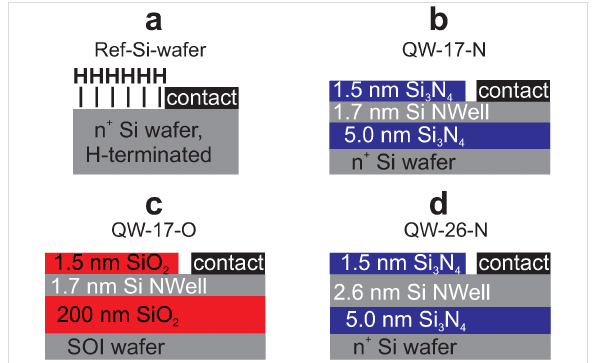
Figure 3: Structures of samples investigated by synchrotron UPS: (a) Si-reference, (b) 1.7 nm Si-NWell in Si 3 N 4 , (c) 1.7 nm Si-NWell in